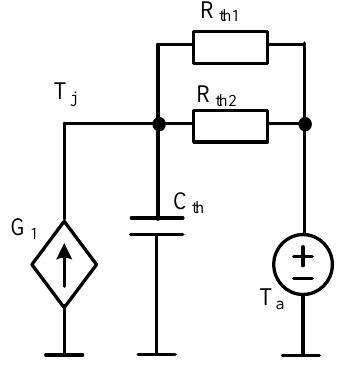
Figure 1. Network representation of the thermal model described in [10 , 39].